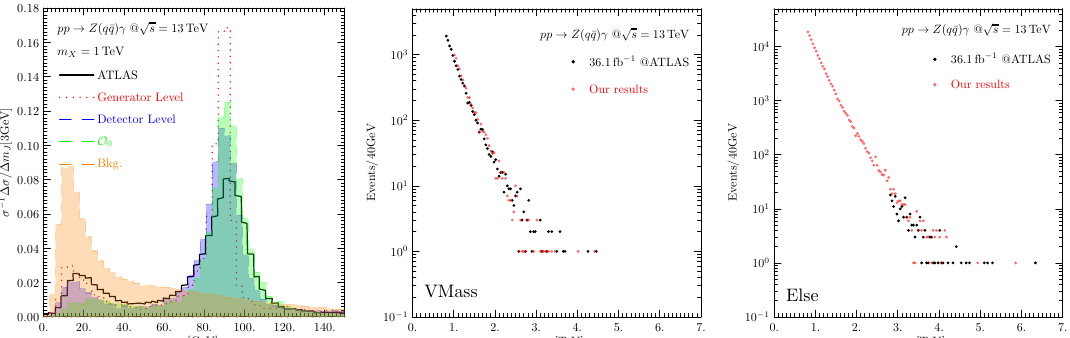
Figure 7 . Validations of our simulation of the hadronic decay mode Z → q ¯ q , assuming a scalar resonance X with mass m X = 1 TeV . The left panel shows the invariant mass distribution of a fat jet emerging from the decay of a highly-boosted Z -boson while the middle and right panels compare distributions of the invariant mass m Jγ for the VMass and Else